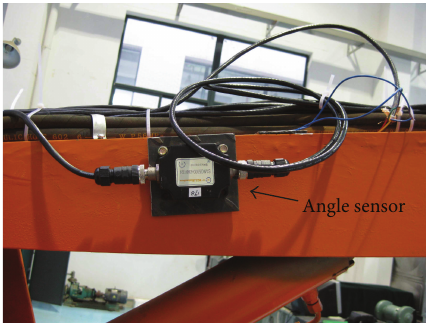
Figure 7: Dewesoft data acquisition process instrument.